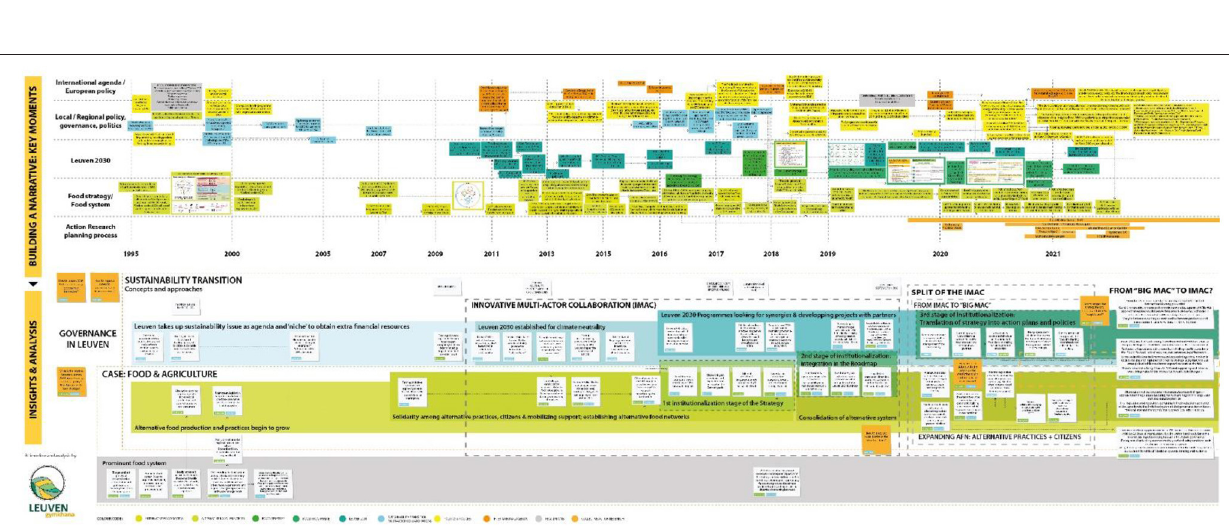
Frontiers in Sustainable Food Systems |